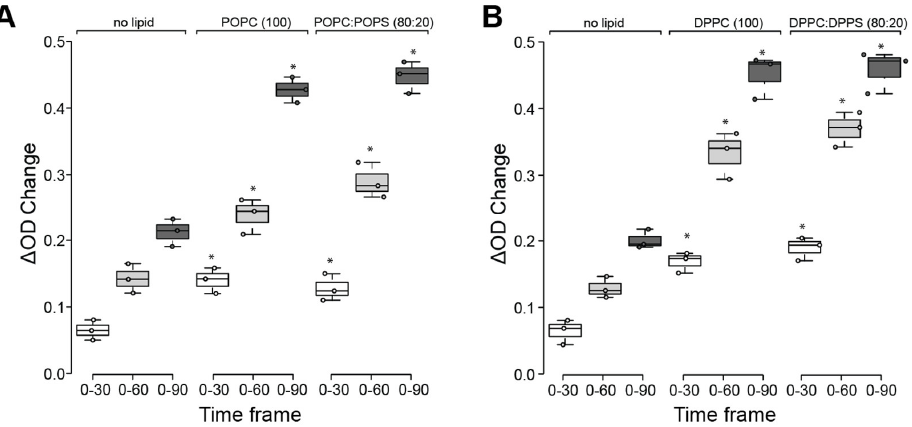
Figure 3. The presence of lipids, but not lipid-binding, increases the ATP hydrolysis activity of